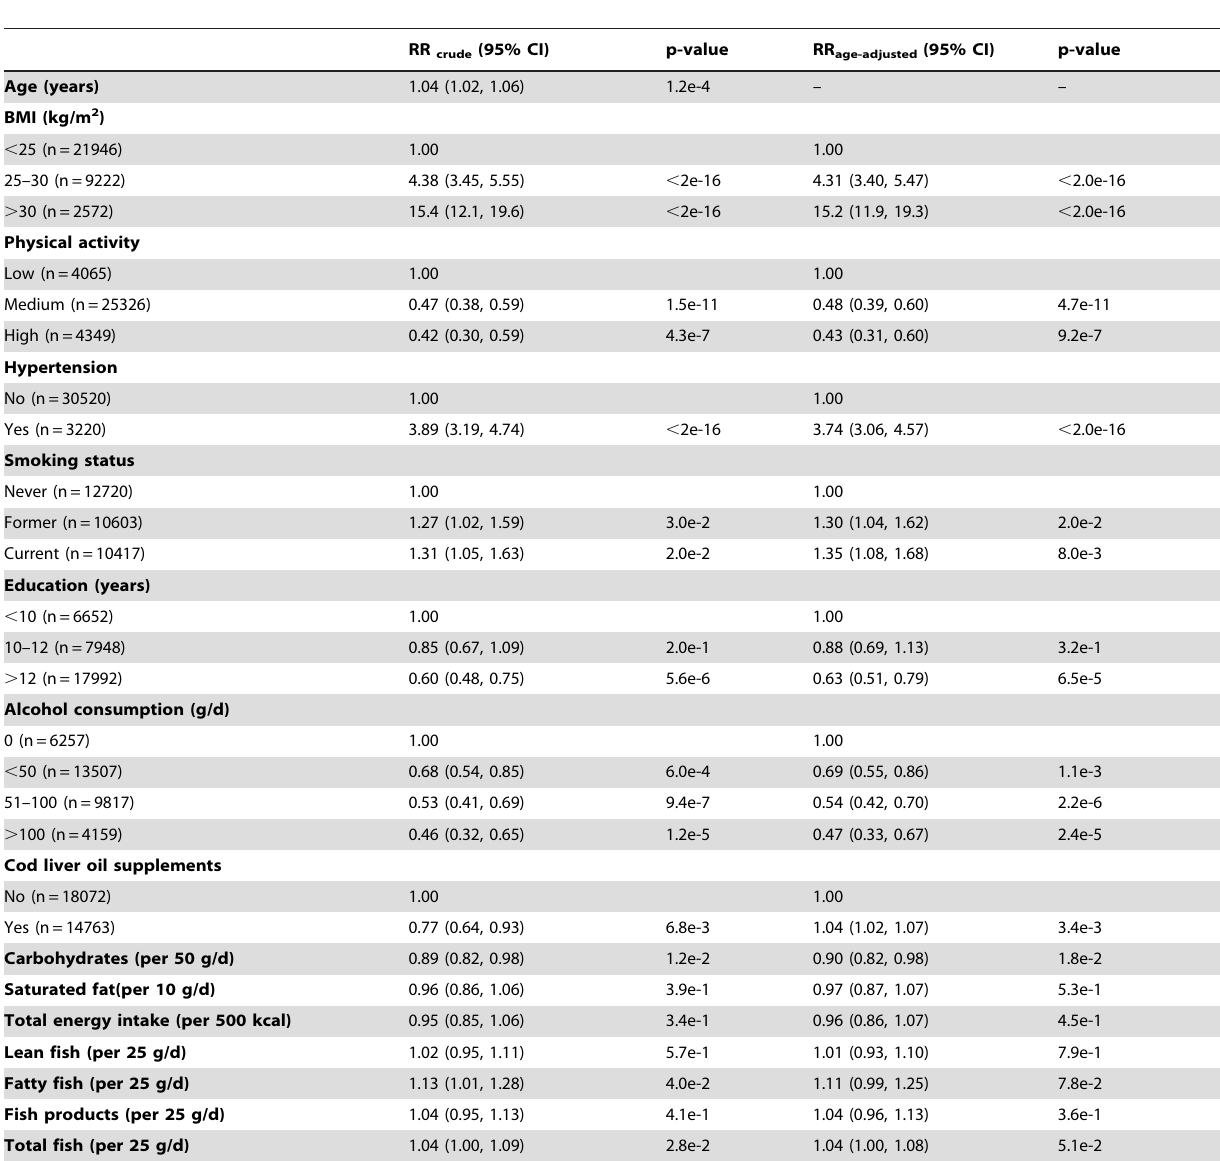
Table 2. Crude risk ratios (RR) with 95% confidence intervals (95% CI) and age-adjusted RR (95% CI) of T2DM in relation to a number of co-variates and exposure